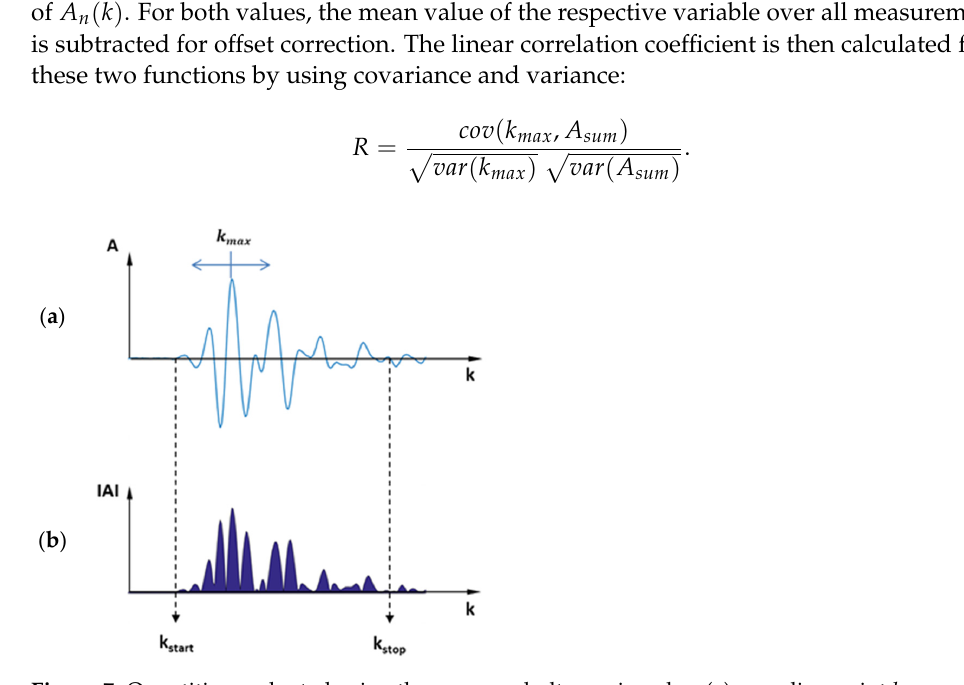
Figure 7. Quantities evaluated using the measured ultrasonic pulse: ( a ) sampling point k max and ( b ) amplitude sum A sum